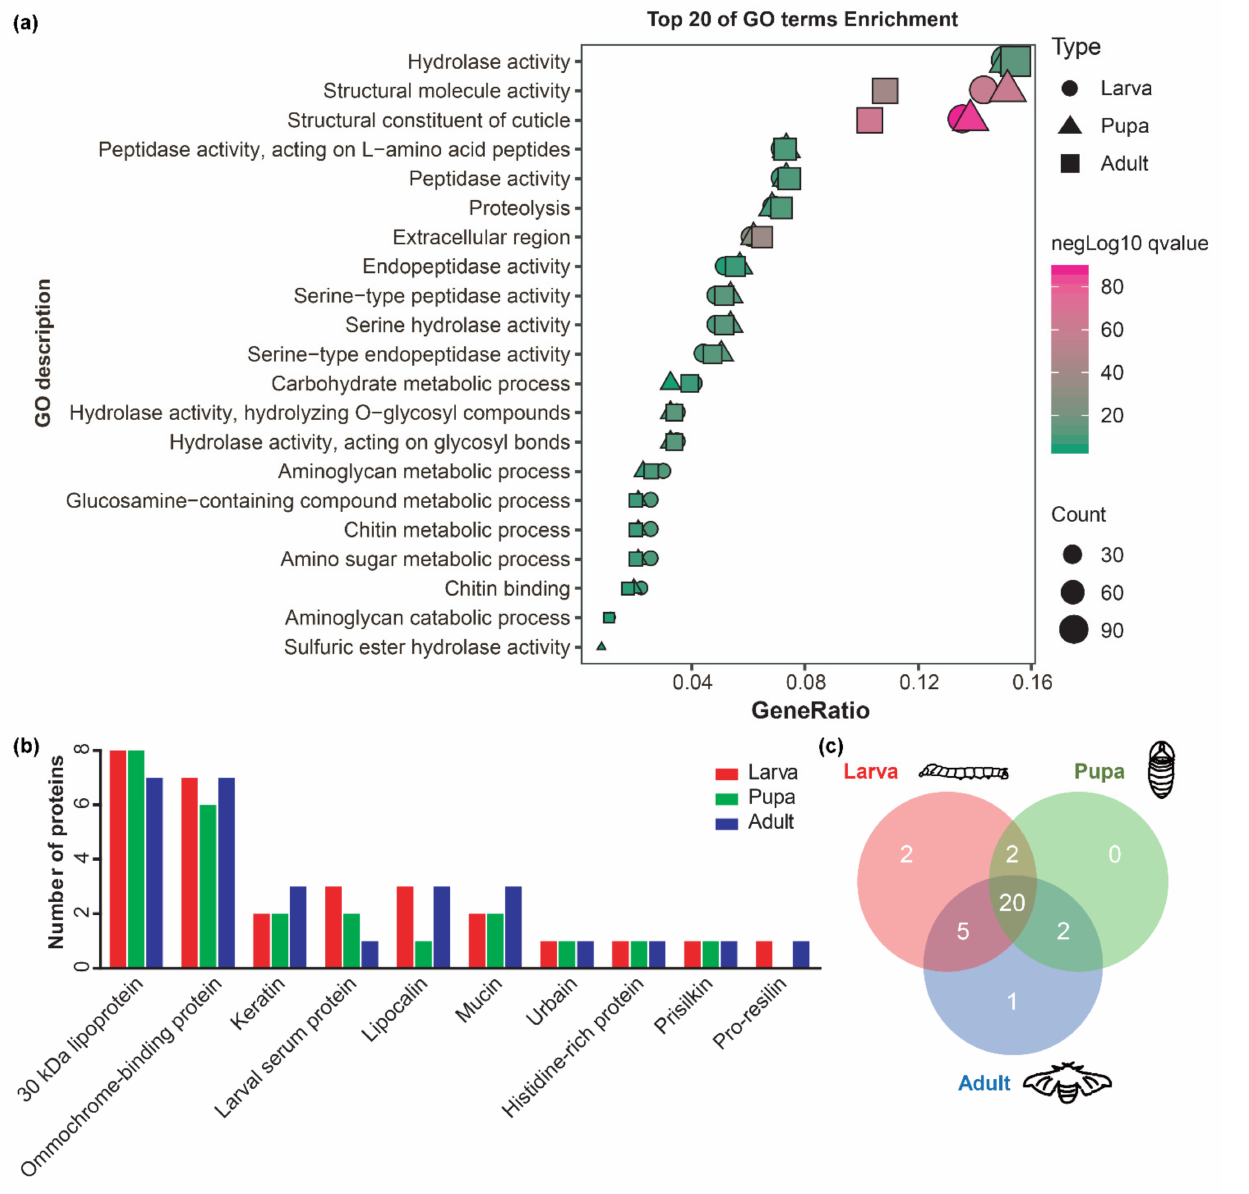
Figure 5. Identification of other protein components involved in larval, pupal, and adult cuticle formations in B . mori . ( a ) GO enrichment analysis of putative proteins involved in larval, pu- pal, and adult cuticle formations. ( b ) The number of the most probable other proteins in each protein family involved in larval, pupal, and adult cuticle formations. The red, green, and blue columns represent the most probable other proteins involved in larval, pupal, and adult cuticle formations. ( c ) Comparison of the most probable other proteins involved in larval, pupal, and adult cuticle